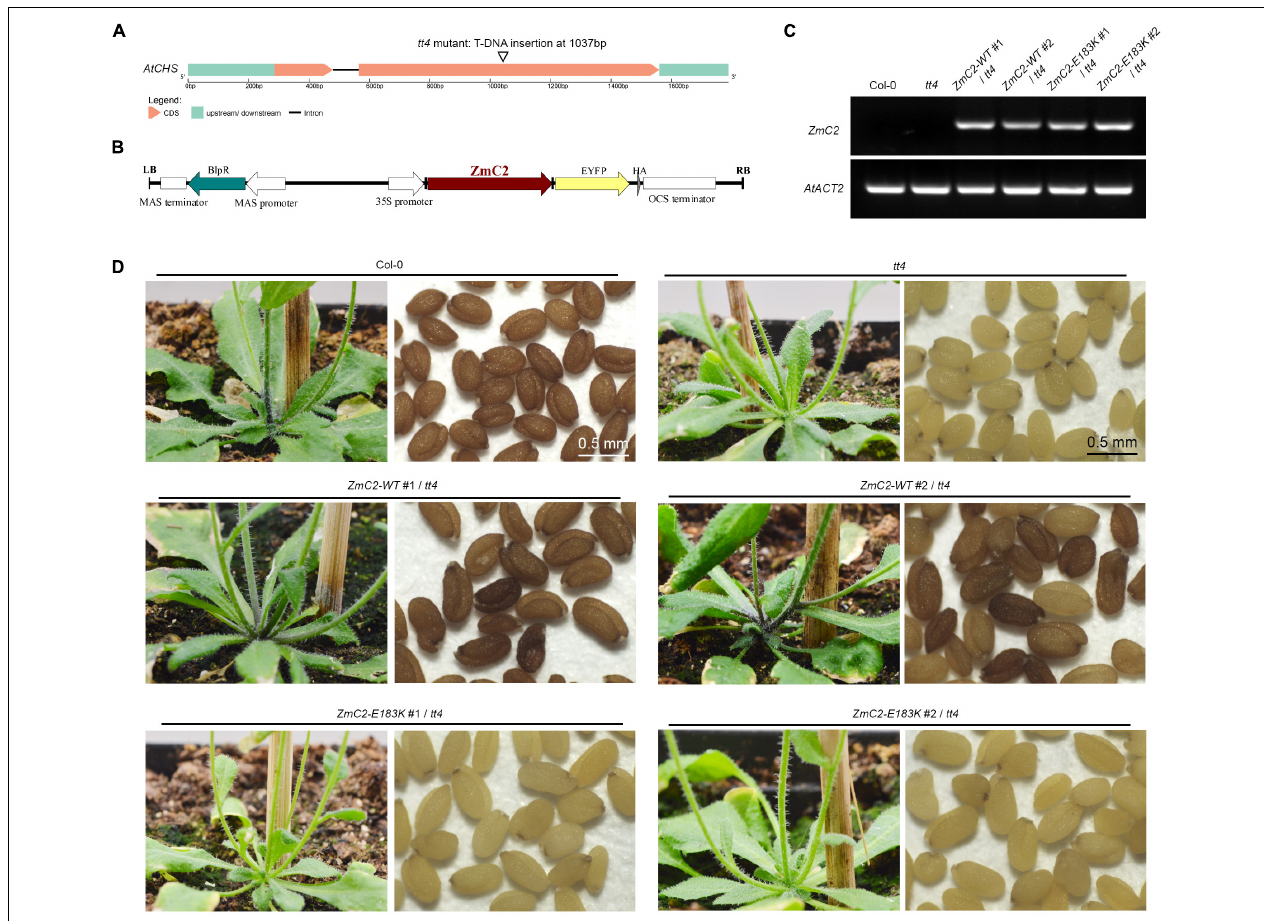
FIGURE 3 | Transformation of ZmC2-WT and ZmC2-E183K in Arabidopsis thaliana tt4 mutant. (A) Structure of Arabidopsis chalcone synthase ( AtCHS , At5g13930) and the tt4 mutant. (B) Schematic diagram of transgene construct from T-DNA leaf border (LB) to right border (RB). (C) RT-PCR detection of ZmC2 in Arabidopsis. AtACT2 [actin 2 ( Arabidopsis thaliana ), At3g18780] was used as internal control. (D) Phenotypic comparison. Two independent transgenic lines were displayed (#1 and #2).